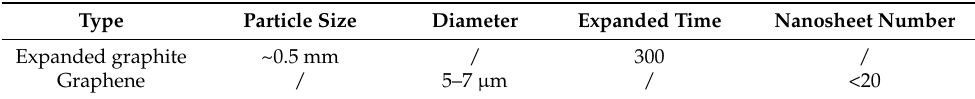
Table 1. Properties of expanded graphite (EG) and graphene nanoplatelets